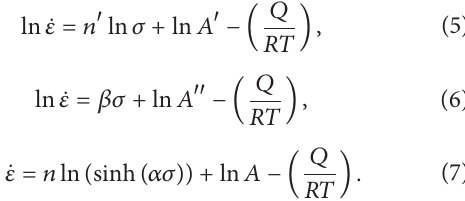
which brings 𝛼𝜎 into the correct range to make constant 𝑇 curves in ln ̇𝜀 versus ln ( sinh (𝛼𝜎)) plots linear and parallel [22, 23]. The power law description of stress (2) is preferred for low stress level while exponential law (3) is suitable for high stress level. However, the hyperbolic sine law (4) can be used for a wide range of temperatures and strain